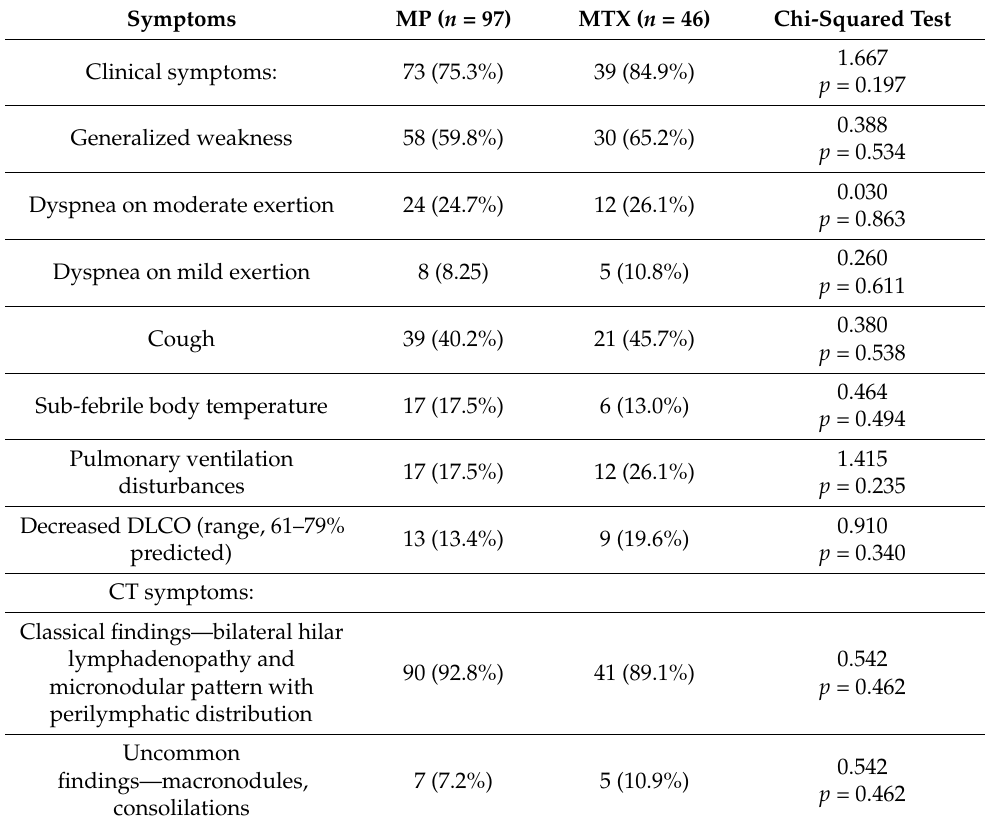
Table 1. Baseline clinical, functional, and CT